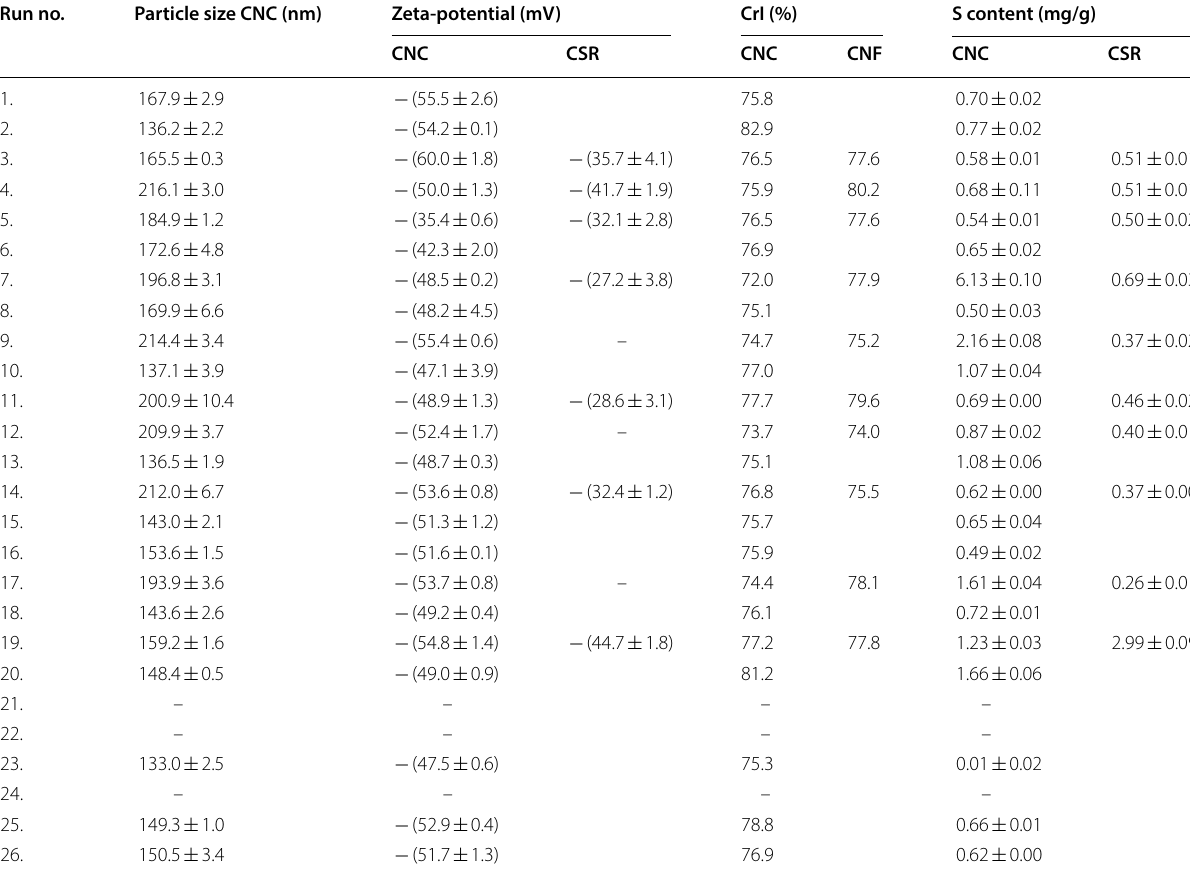
*Zeta-potential of CSR from runs 9, 12 and 17 is not reported due to large fluctuations resulting from aggregation and sedimentation of large sized fibers